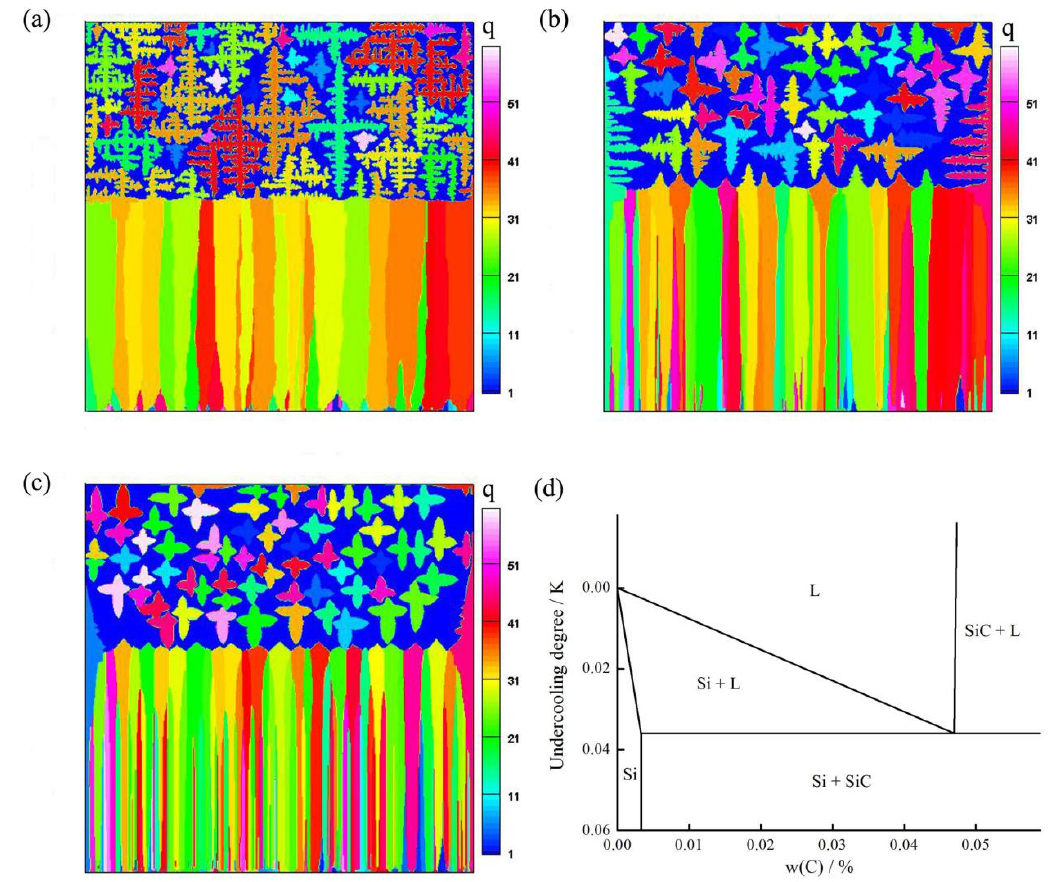
Figure 6. Equiaxed crystal morphologies: ( a ) C 01 = 0.003 wt.%; ( b ) C 02 = 0.01 wt.%; ( c ) C 03 = 0.04 wt.%; ( d ) Phase diagram of C-Si system.